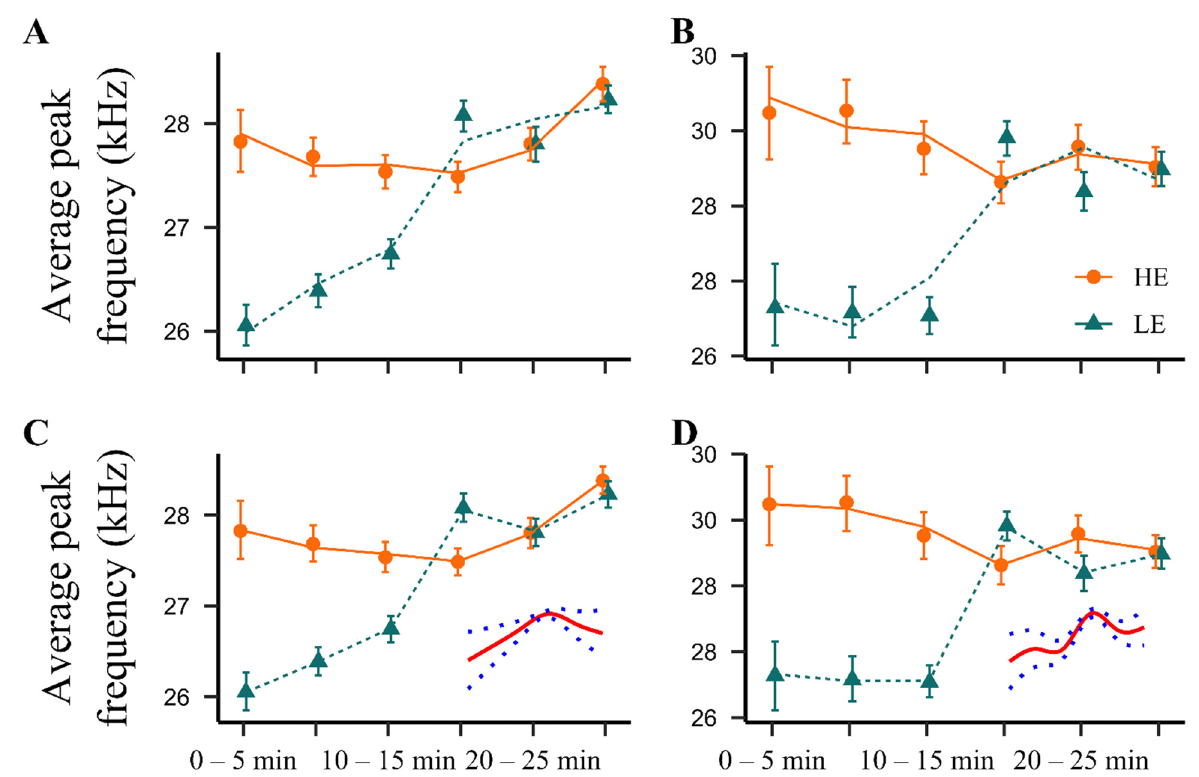
Figure 4. Average peak frequency of NPS-induced (1 nmol, i.c.v.) 22 kHz calls. Symbols: Observed time-binned average peak frequencies of long ( A , C ) and short ( B , D ) 22 kHz USVs (error bars indicate 95% confidence limits for the population mean obtained by nonparametric bootstrap). Lines: Model-based predictions from LMM ( A , B ) and GAM ( C , D ; difference in splines added). HE: high exploring rats; LE: low exploring rats; NPS: neuropeptide S. HE NPS ( n = 9); LE NPS ( n = 10).